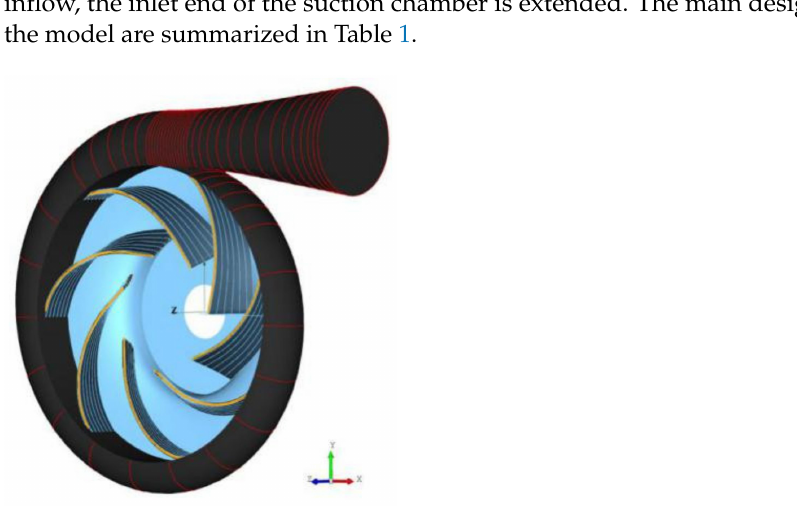
Figure 1. Geometric model of the centrifugal pump with an open volute. Table 1. Main design parameters of the